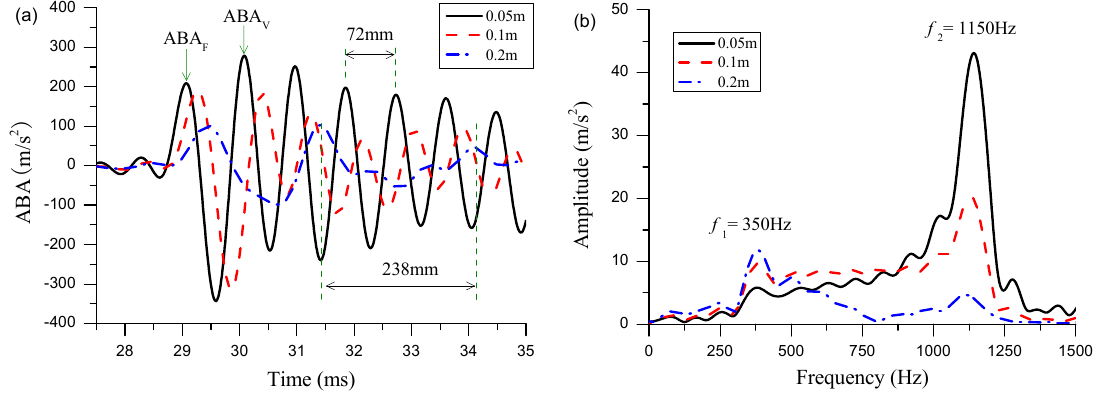
Figure 10. The response of ABA under excitation of rail welds at different wavelengths in ( a ) time and ( b ) frequency domains.